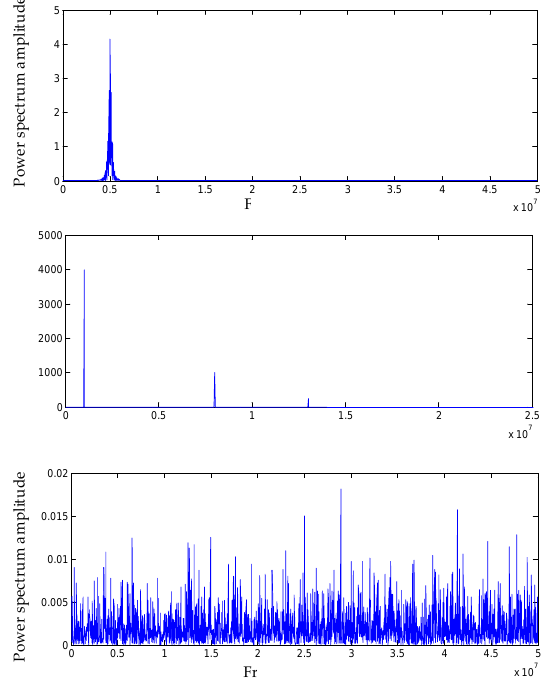
Figure 5. Discrete Fourier transformation (DFT) power spectrum of di ff erent components in noisy pulse.